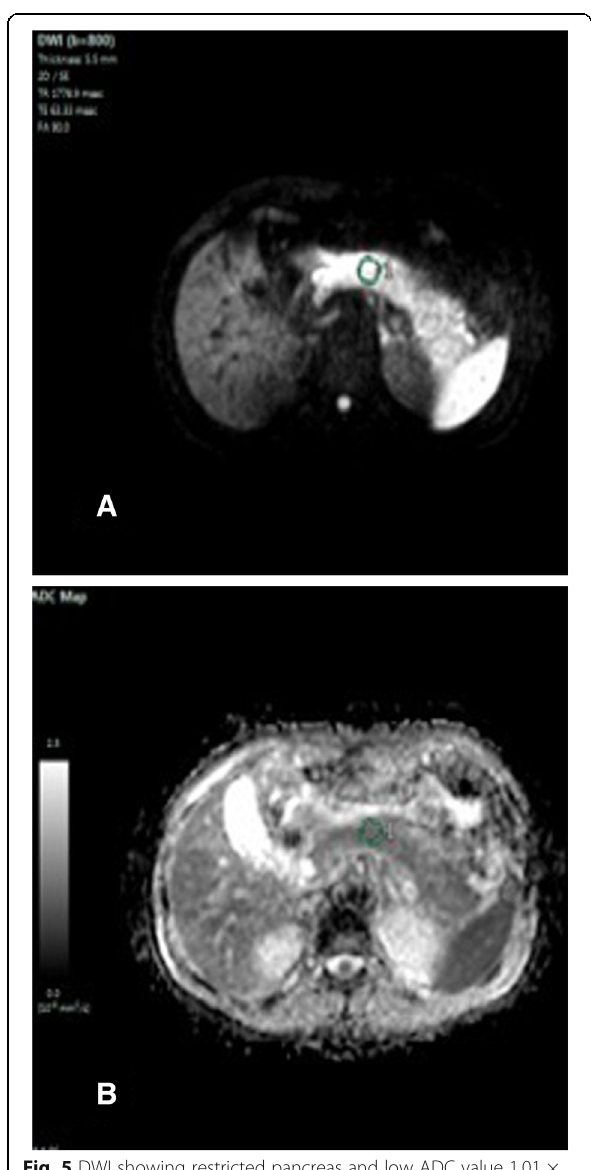
Fig. 5 DWI showing restricted pancreas and low ADC value 1.01 × 10 − 3 mm 2 /s of pancreatic body on ADC